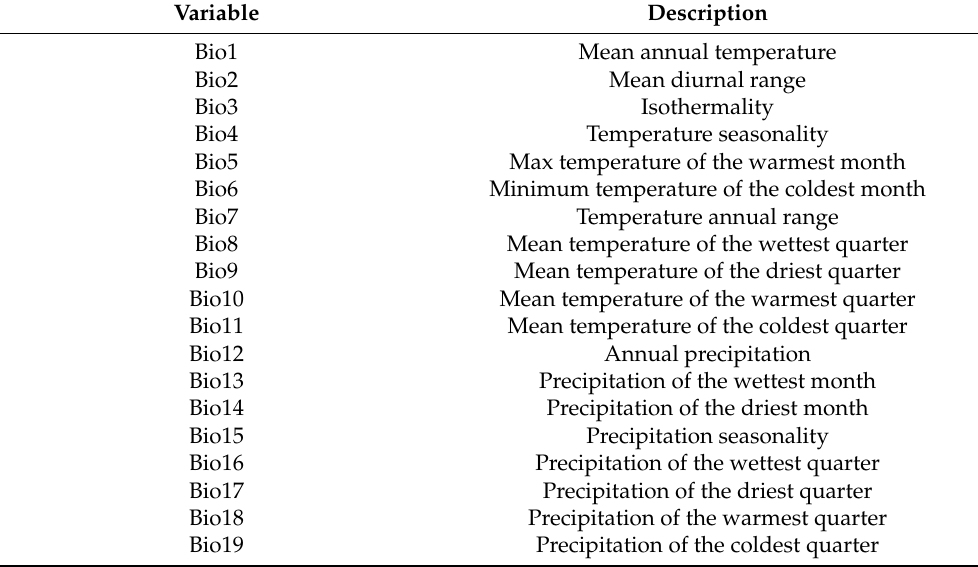
Table 1. Bioclimatic variables’